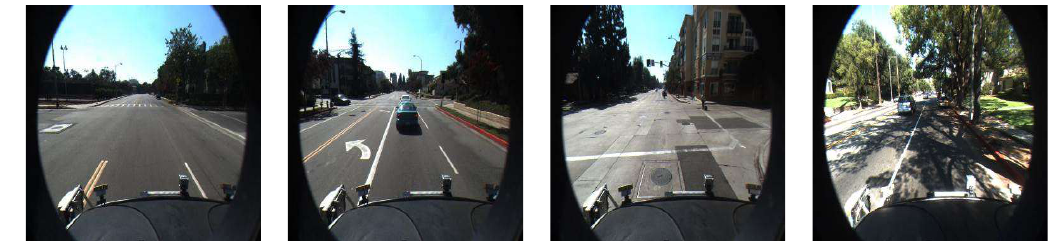
Figure 14. Caltech data sets.